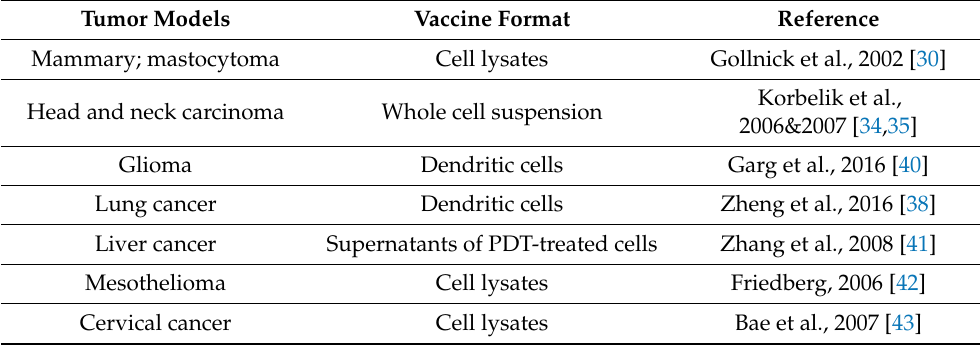
Table 1. PDT-generated cancer vaccines: pre-clinical studies with mouse tumor models. Tumor Models Vaccine Format Reference Mammary; mastocytoma Cell lysates Gollnick et al., 2002 [30] Korbelik et al., Head and neck carcinoma Whole cell suspension 2006&2007 [34,35] Glioma Dendritic cells Garg et al., 2016 [40] Lung cancer Dendritic cells Zheng et al., 2016 [38] Liver cancer Supernatants of PDT-treated cells Zhang et al., 2008 [41] Mesothelioma Cell lysates Friedberg, 2006 [42] Cervical cancer Cell lysates Bae et al., 2007